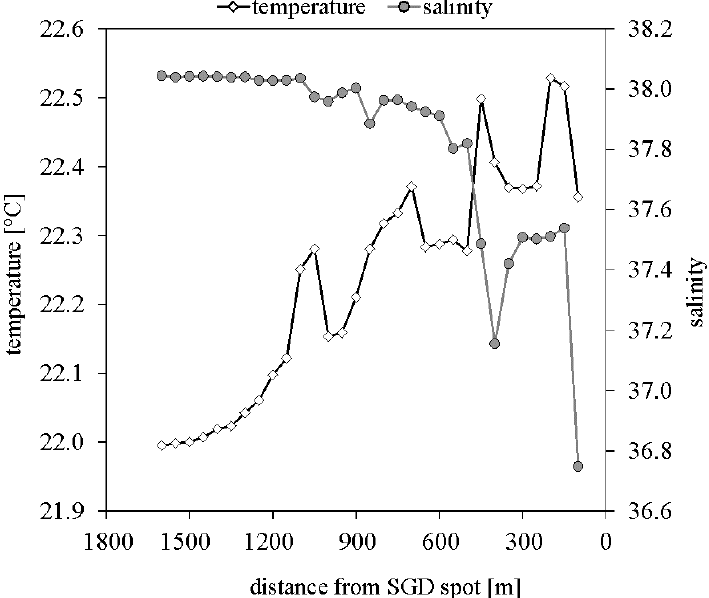
Figure 7. Water salinity and temperature along the